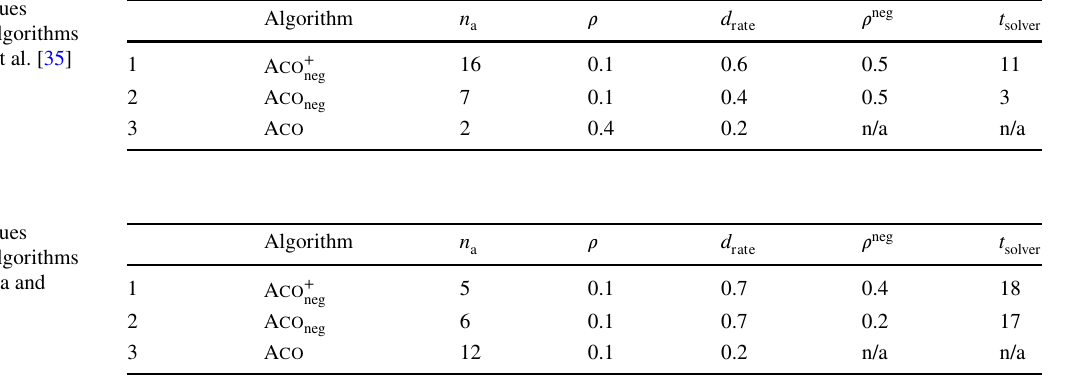
Table 8 Parameter values obtained for all A CO algorithms concerning the Pinto et al. [35] instances